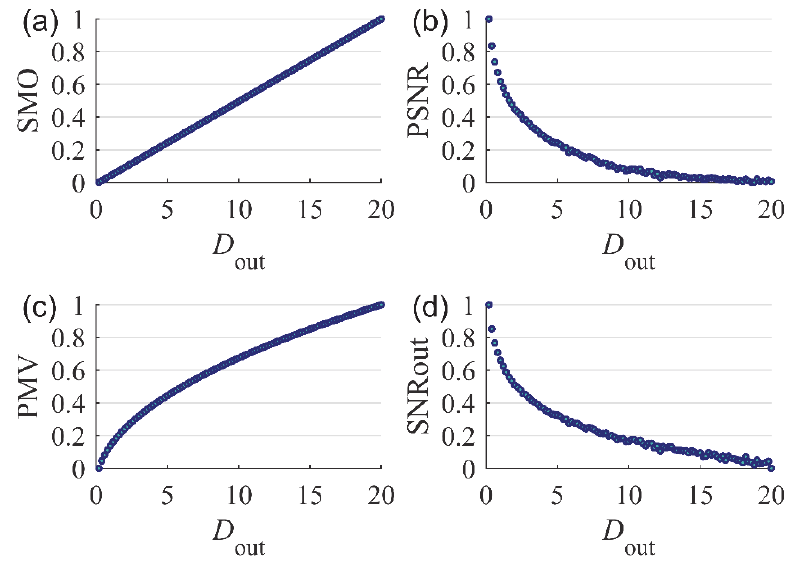
Figure 4. Distribution of normalized samples with D out : ( a ) smoothness (SMO); ( b ) peak signal ‐ to ‐ noise ratio (PSNR); ( c ) piecewise mean value (PMV); ( d ) system output signal ‐ to ‐ noise ratio (SNR out ). ratio (PSNR); ( c ) piecewise mean value (PMV); ( d ) system output signal-to-noise ratio (SNR out